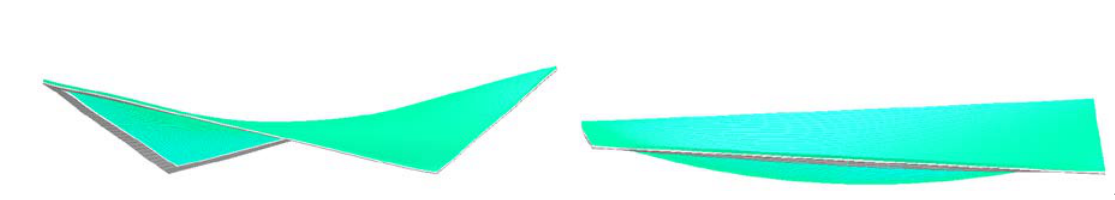
Fig. 8 Load step I: cold bending (left), load step II: cold-bent model under pressure load